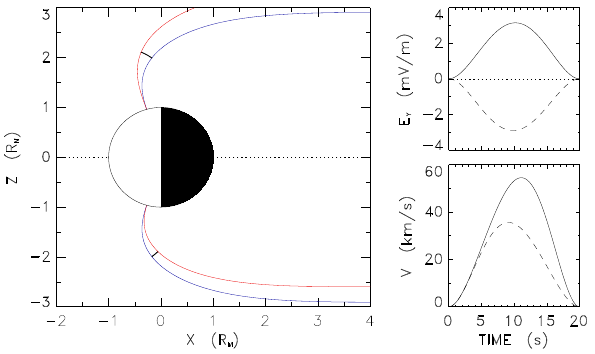
Fig. 3. (Left) Evolution of a given magnetic field line from IMF B X = 0 (blue color code) to IMF B X = 20nT (red color code). In both hemispheres, the black line shows the E × B drift path of a zero energy particle during the IMF turning. (Right top) Electric field and (right bottom) E × B drift speed versus time. The time scale of the IMF turning is set to